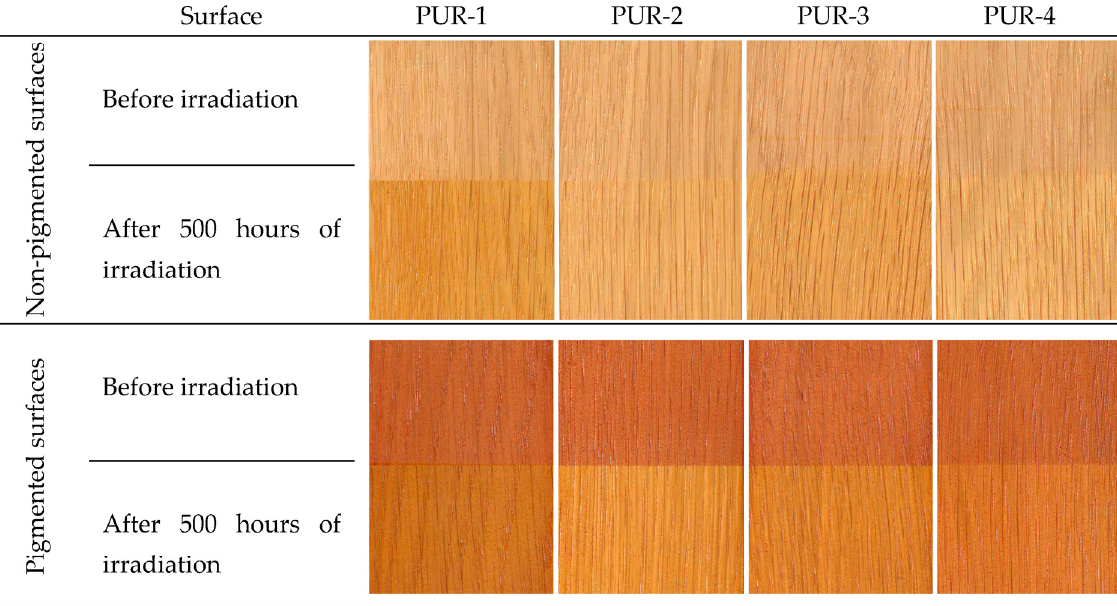
Figure 6. Colour of oak wood surfaces coated with specific lacquers before and after irradiation in the accelerated aging process.